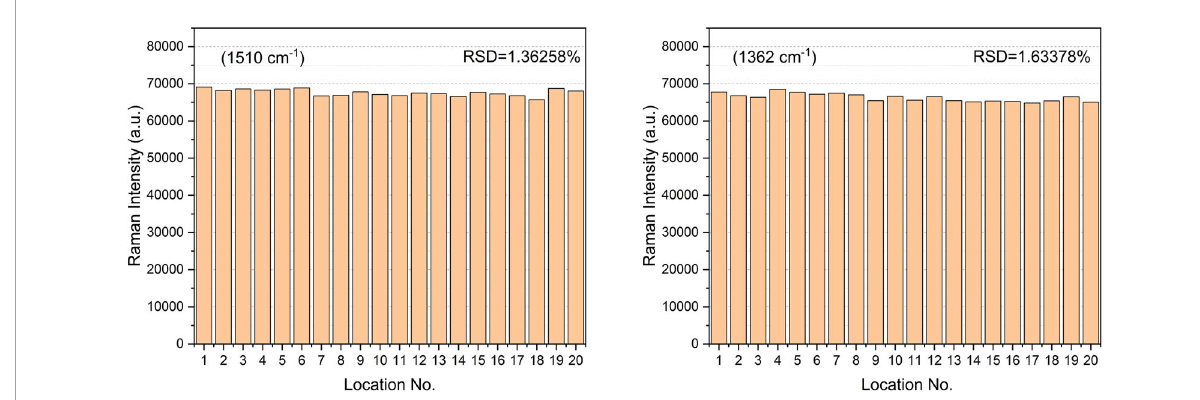
FIGURE3 SERS spectral intensity of R6G (10 − 4 mol · L − 1 ) measured at 20 positions on Au-NPs substrate.